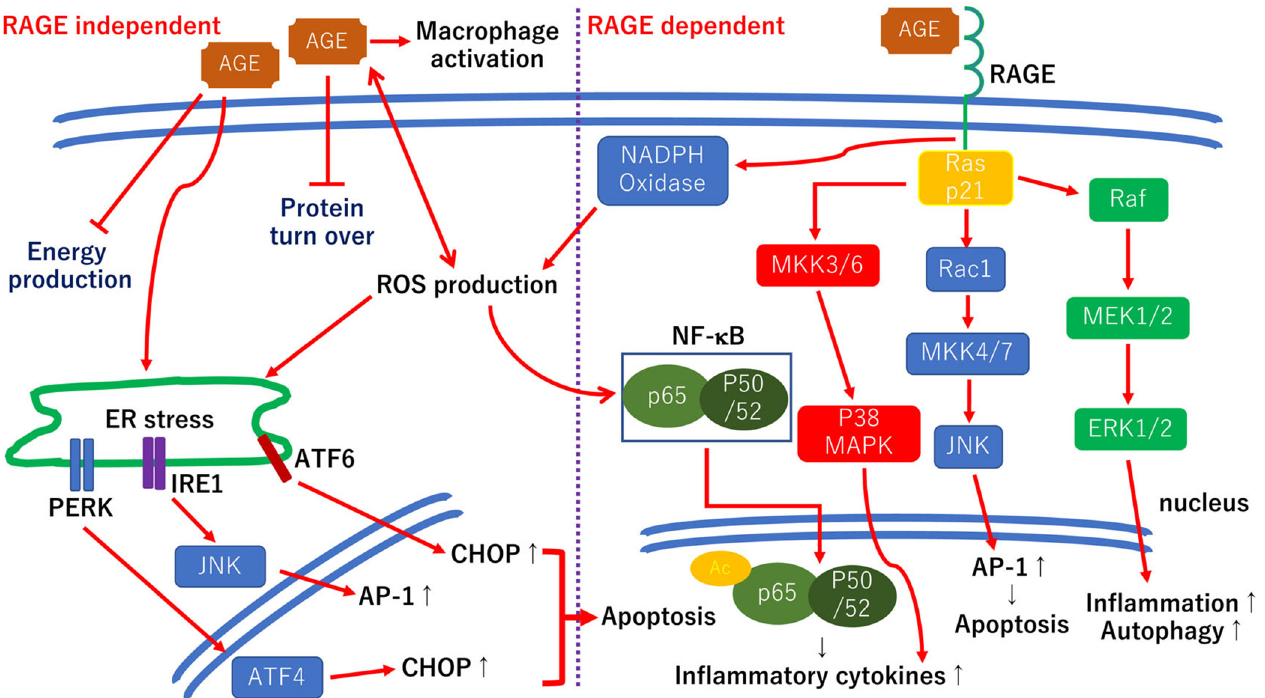
Figure 4. Hypothetic scheme for both RAGE-dependent and RAGE-independent cellular signaling pathways. The AGE-RAGE-dependent signaling pathways activate various cellular downstream pathways including the NADPH–NF– κ B axis and the Ras–MAPK axis, which result in inflammatory reactions [95]. The Ras–ERK1/2 axis is also involved in the inflammatory reactions. The Ras-c-Jun N-terminal kinase (JNK) axis is associated with apoptotic cell death. The RAGE-independent pathway is involved in the BM thickening by disturbing the ECM protein turn-over rate [59,60]. The AGEs upregulate the CCAAT-enhancer-binding protein homologous protein (CHOP) levels and induce endoplasmic reticulum (ER) stress-related cell death in retinal pericytes [96]. In addition, AGEs, and Amadori products become the source of the ROS. Raf: rapidly accelerated fibrosarcoma; Rac1: PAS-related C3 botulinus toxin substrate 1; MEK1/2: MAPK ERK kinase 1/2; MKK4/7: mitogen-activated protein kinase 4/7; MAPK: mitogen-activated protein kinase; PERK: protein kinase-like ER eukaryotic initiation factor-2 alpha kinase; IRE1: inositol-requiring ER-to-nucleus signaling protein 1; ATF4, 6: activating transcription factor-4, -6; Ac: